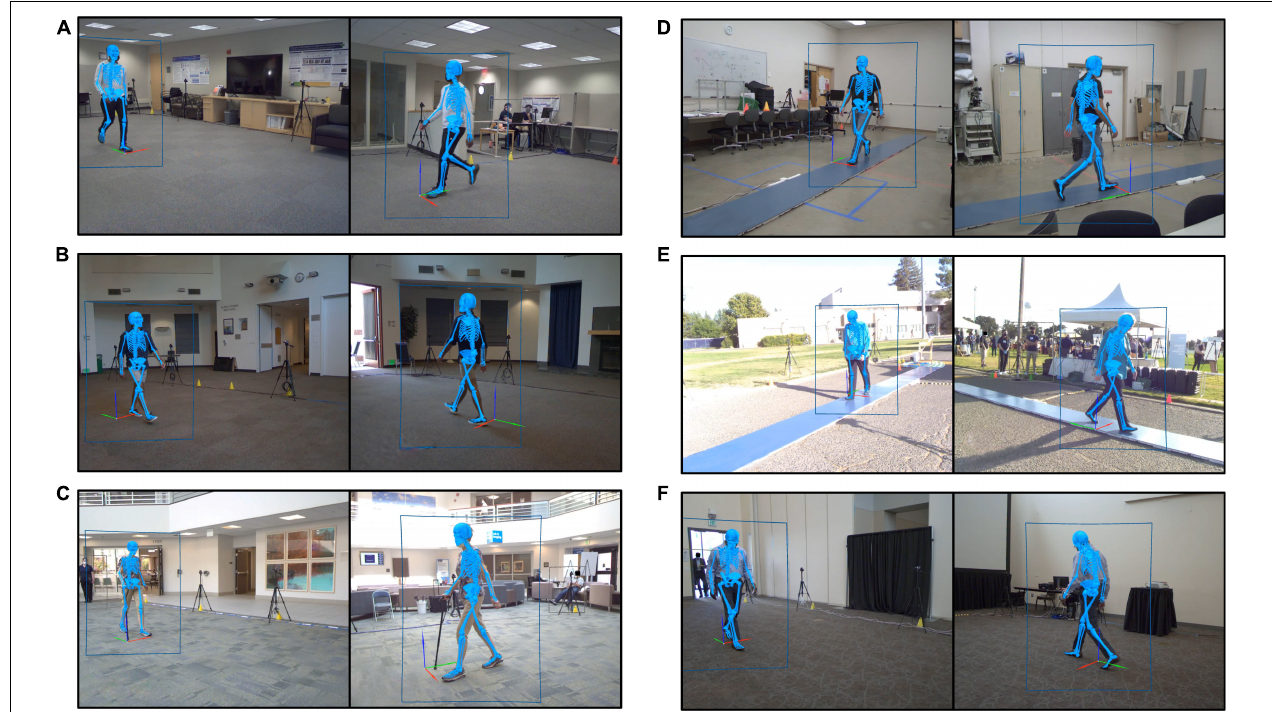
FIGURE 1 | Still images recorded by the markerless motion capture video cameras during gait experiments performed at each of the six experimental locations. Each image shows a participant walking. Human pose identification is indicated by the blue rectangle outlining the participant. The estimated three-dimensional pose generated by Theia3D is represented by the blue skeleton overlaid on the subject image. (A) Location 1, spare office-style room. (B) Location 2, community event room. (C) Location 3, clinic-adjacent lobby. (D) Location 4, spare storage-style room. (E) Location 5, outdoor event at a sports field. (F) Location 6, conference center breakout